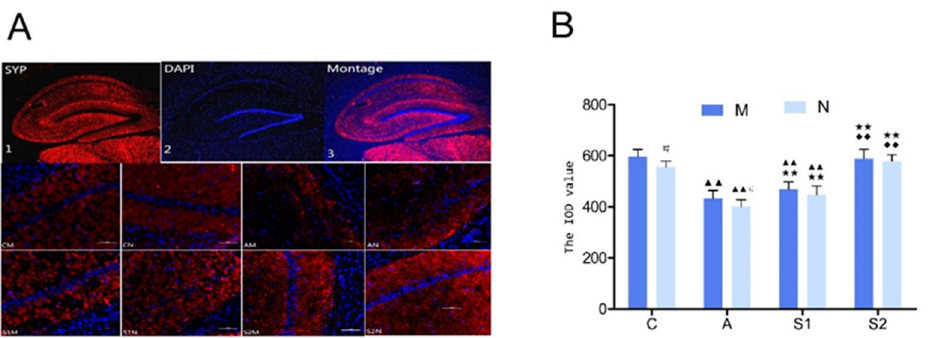
Figure 4. ( A ): Representative images showing the expression levels of synaptophysin (Syp) in the rat hippocampal dentate gyrus (DG) region, which were assessed by immunofluorescent staining and captured by laser confocal scanning microscopy (× 200 magnification; the scale bar indicates a length of 100 µm). The red fluorescence was Syp of Cy3, blue fluorescence was the nuclei of DAPI-labeled hippocampal neurons, and the superimposed image. ( B ): Changes of integral optical density (IOD) levels of Syp in the hippocampus DG region, which were calculated by image processing analysis. Data are presented as Mean ± SD ( n = 10/group). The in-graph symbols indicate: ▲▲ p < 0.01 versus Group C ; ** p < 0.01 versus Group A ; ◆◆ p < 0.01 versus Group S1 ; # p < 0.05 versus Group M .